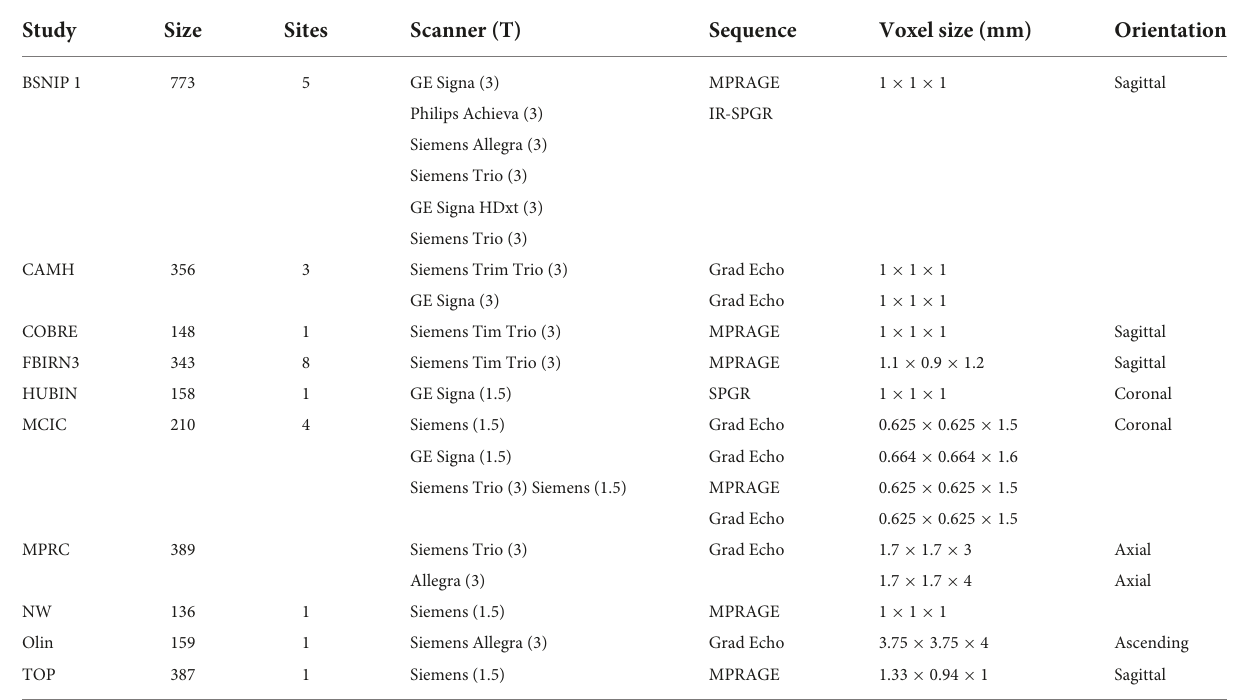
TABLE 1 Scanning and site information for each